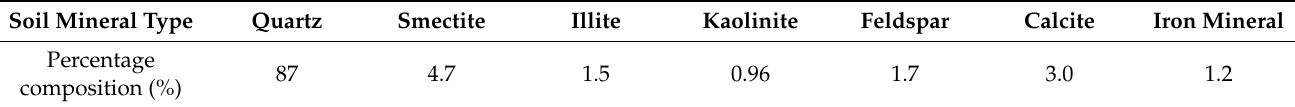
Table 2. Mineral composition of the initial pot